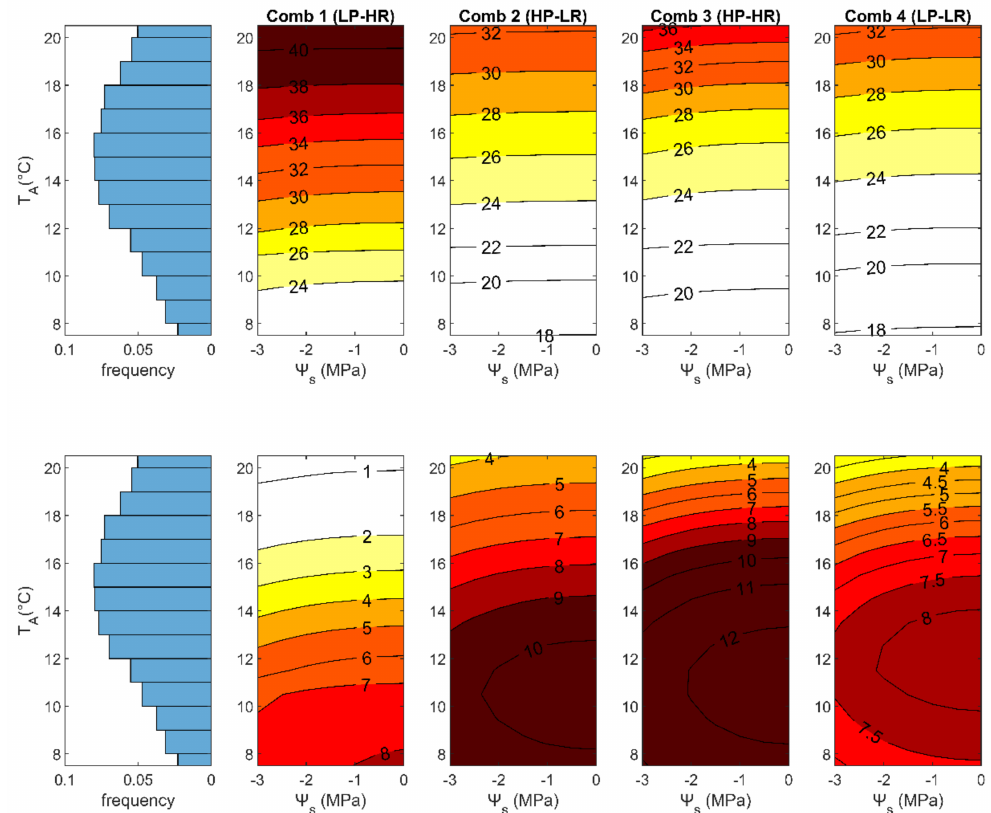
Figure 3. Leaf temperatures (top row; in ◦ C ) and net assimilation rates (bottom row; in µ mol m –2 s –1 ) for di ff erent air temperatures and soil water potentials. Four trait combinations are explored (Table 2). The lowest air temperature corresponds to the median day for the growing season 2005. As a term of comparison, the left column shows the frequency of the air temperature at midday reported in the study site during the growing seasons from 1996 to 2016. LP-HR: Low Productivity-High Risk of thermal damage; HP-LR: High Productivity-Low Risk of thermal damage; HP-HR: High Productivity and High Risk of thermal damage; and LP-LR: Low Productivity and Low Risk of thermal